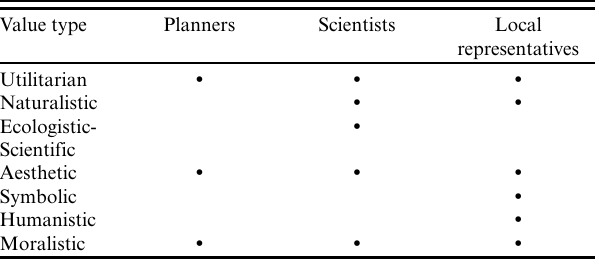
Table 3 . Values inferred from the narratives of stakeholders during the interview and mapping